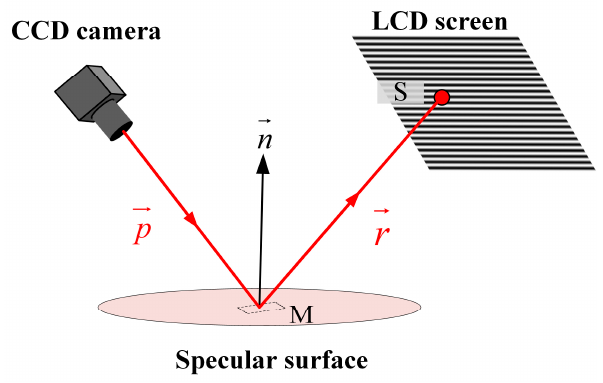
Figure 2. Sketches of MPMD can be drawn in ray tracing with a probe from the camera.